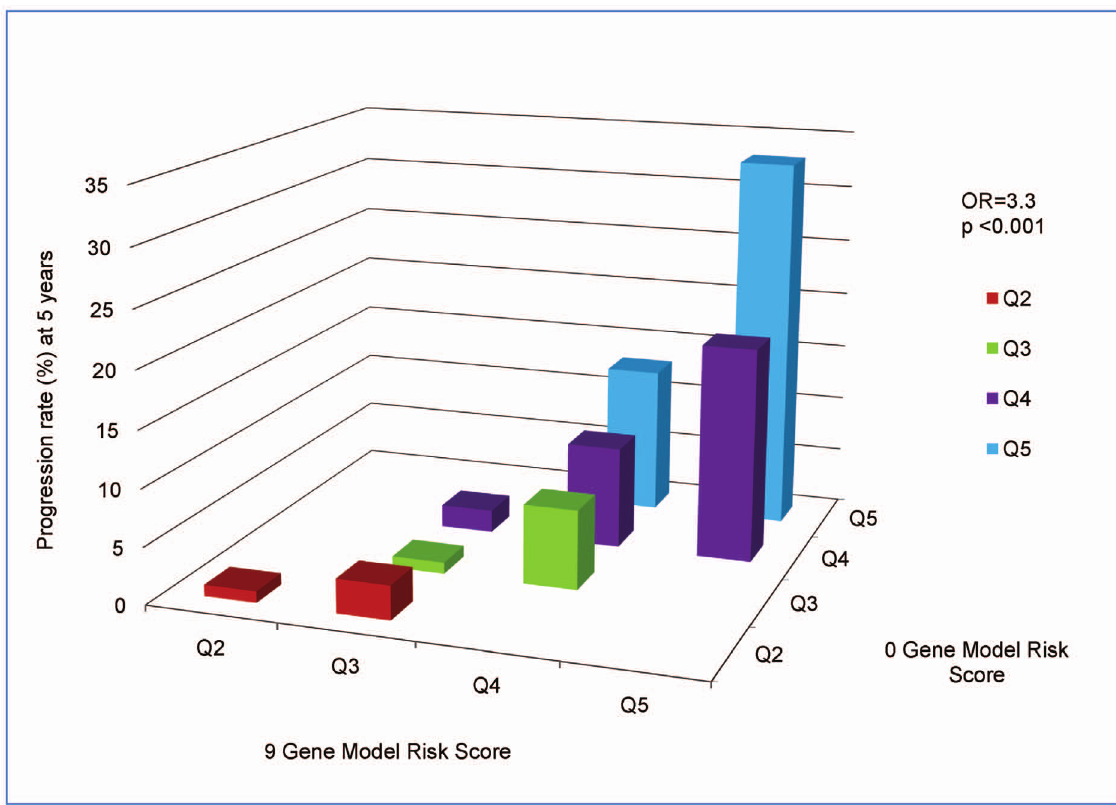
Figure 3. Cross-Classification of Progression Rates to Geographic Atrophy: 9 Gene Model vs 0 Gene Model. Cross-classification of subjects progressing to Geographic Atrophy by risk score quintile for 9 and 0 gene models, with estimated progression rates for each combination of a 9 gene quintile by 0 gene quintile. OR=odds ratio of progression per one quintile increase in 9 gene model, holding 0 gene model quintile constant.